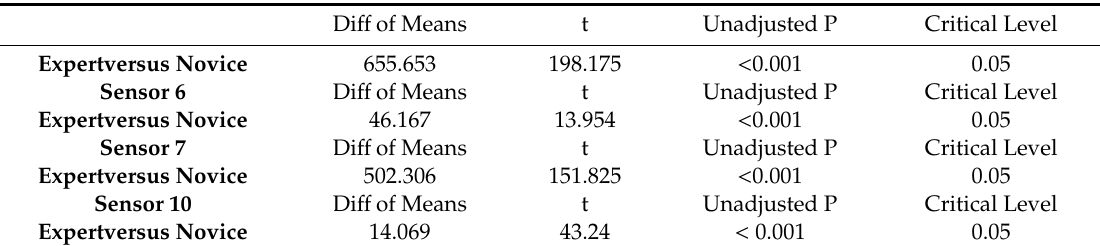
Table 4. Statistics and probability limits from the Holm-Sidak post-hoc comparisons for e ff ects of expertise within each sensor.